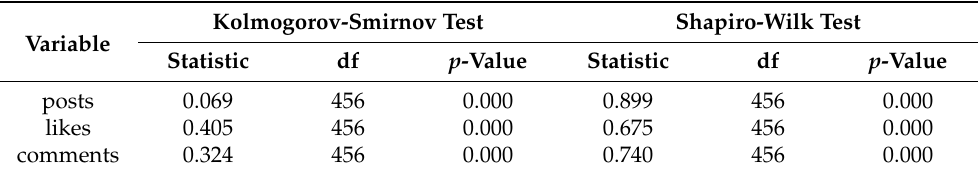
Table 2. Kolmogorov–Smirnov and Shapiro–Wilk test (posts, likes and comments).